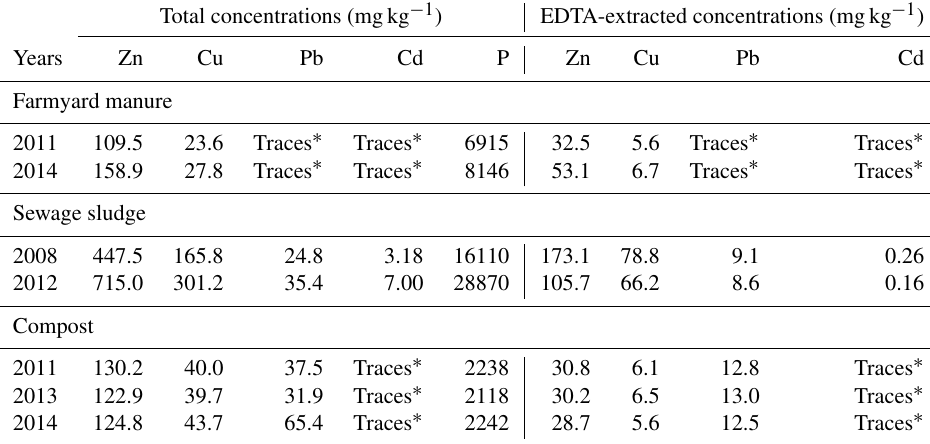
Table 2. Total and EDTA-extractable concentrations of Zn, Cu, Pb, Cd and P relative to the total dry matter of the organic amendment samples from available